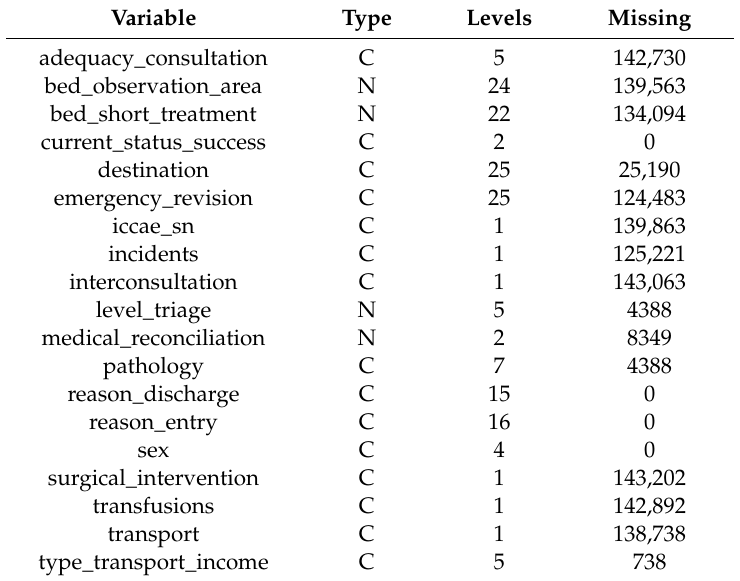
Table 2. Description categorical